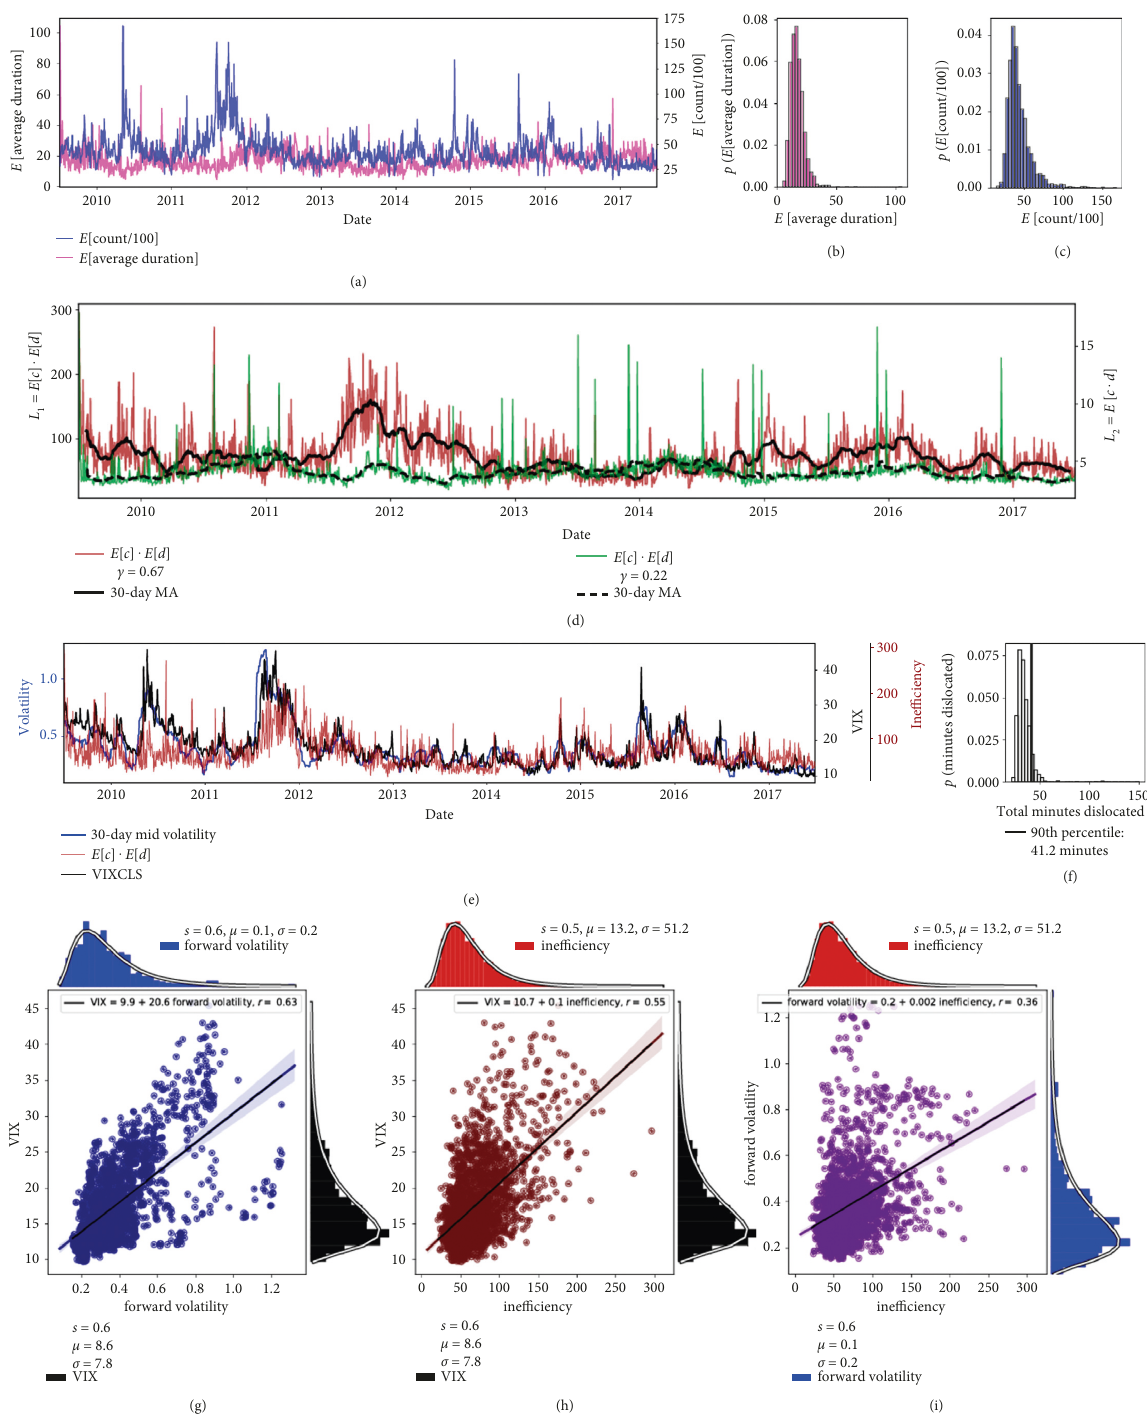
Figure 5: (a) Time series of average duration d and counts c of dislocation segments, which are computed and averaged across trading symbols for each day in the study period. (b, c) Histograms that capture the distribution of values assumed by the time series depicted in (a). (d) Two additional time series derived from the duration and count time series that provide an indicator for the intensity of information � E [ c ] · E [ d ] and I � E [ c · d ] . (e) The correlation asymmetry that may have occurred on a particular trading day. These are defined as I 1 2 and two measures of volatility. (f) The distribution of total dislocated minutes over trading symbols. (g–i) Joint distributions of between I 1 forward volatility, VIX, and I along with marginal distributions of each statistic, which are well characterized by the lognormal probability 1 density